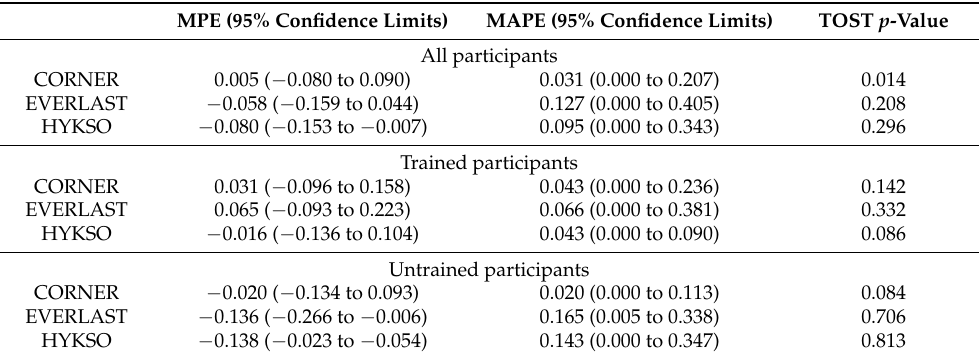
Table 4. Summary results for each punch tracker across all participants, trained participants, and untrained